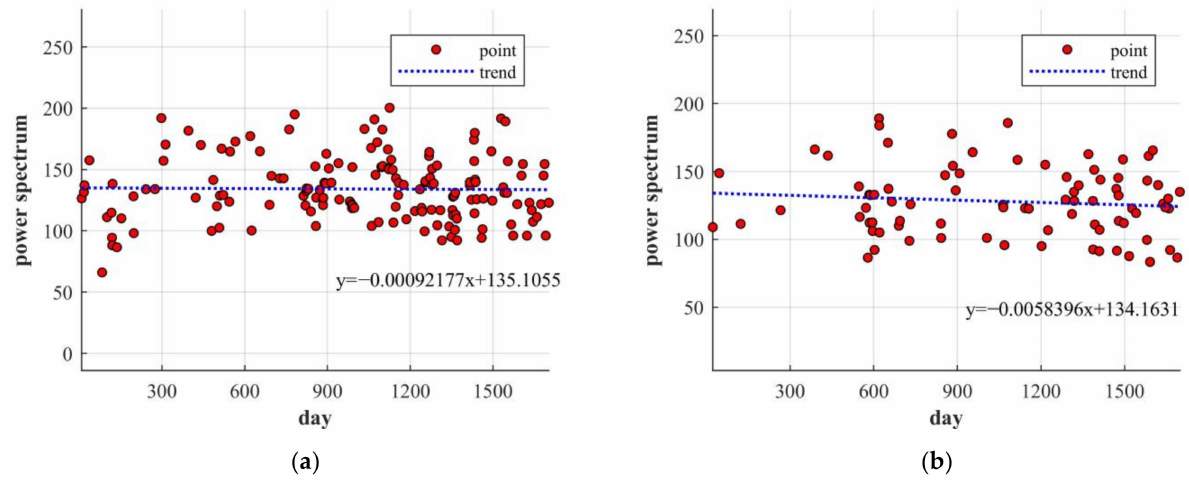
Figure 8. Trend of the power spectrum with time in Chifeng ( a ) and Zhenzhou ( b